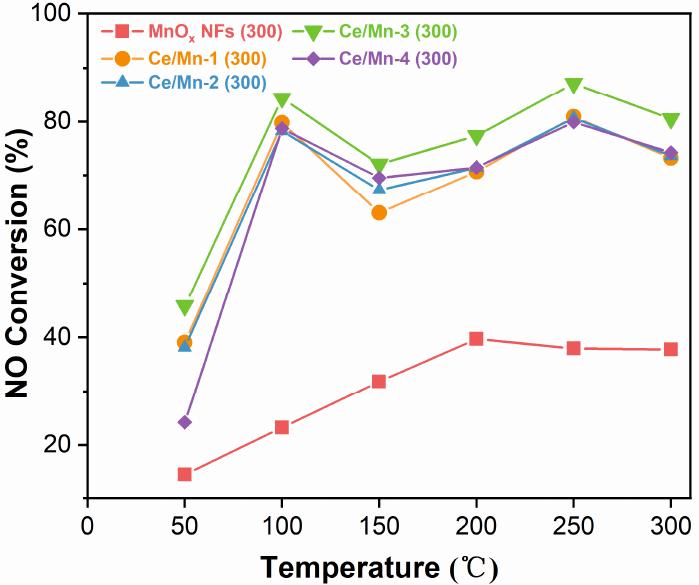
Figure 3. NO conversion curves of MnO 2 NFs and CeO 2 -MnO 2 catalysts with different Ce/Mn ratios.